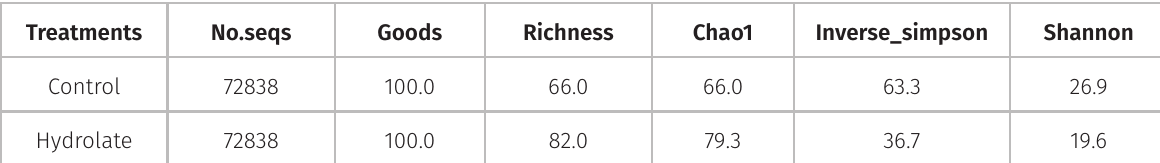
Table V. Richness, Chao1 and the diversity indexes, Shannon and Inverse Simpson, of gut microbiota from Nile tilapia ( Oreochromis niloticus ) fed a diet supplemented with Curcuma longa hydrolate. Treatments No.seqs Goods Richness Chao1 Inverse_simpson Shannon Control 72838 100.0 Hydrolate